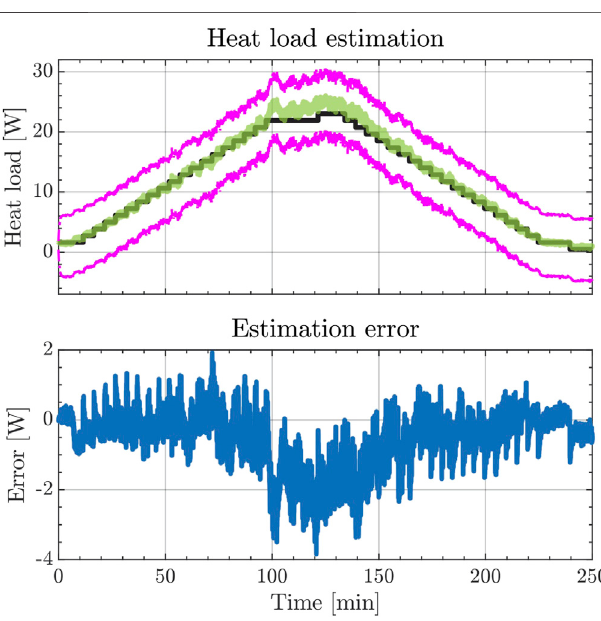
FIGURE 7 | Estimated heat loads (green) and uncertainty (magenta) vs. electrical heater setpoint